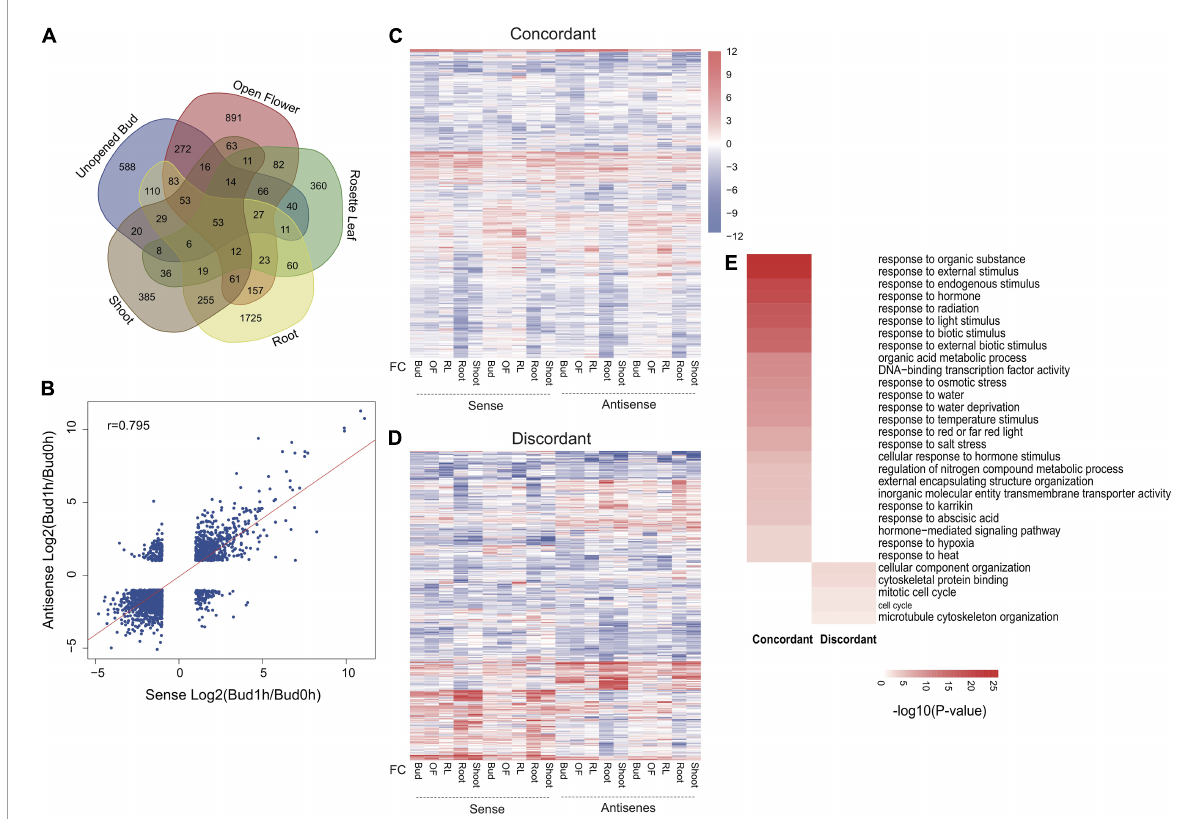
FIGURE3 Response of NAT pairs under heat treatment. (A) Venn graph for differentially expressed genes of NATs between different tissues. (B) Correlation analysis using expression level of sense and antisense genes of NAT pairs under heat treatment. (C) Heatmap for concordant NATs pairs with response to heat stress. (D) Heatmap for discordant NATs pairs with response to heat stress. (E) Top 30 specifically enriched GO terms for concordant and discordant NAT